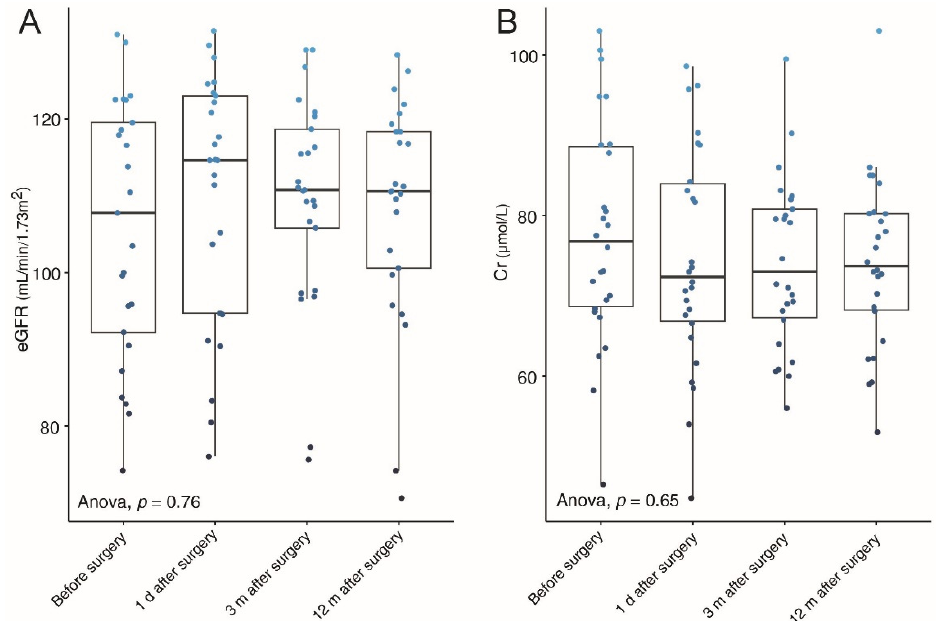
Figure 5. Trends of estimated glomerular filtration rate (eGFR) ( A ) and serum creatinine (Cr) ( B ) from preoperative to postoperative. The blue dots on images represent the values of eGFR or Cr. d = day; m = month.